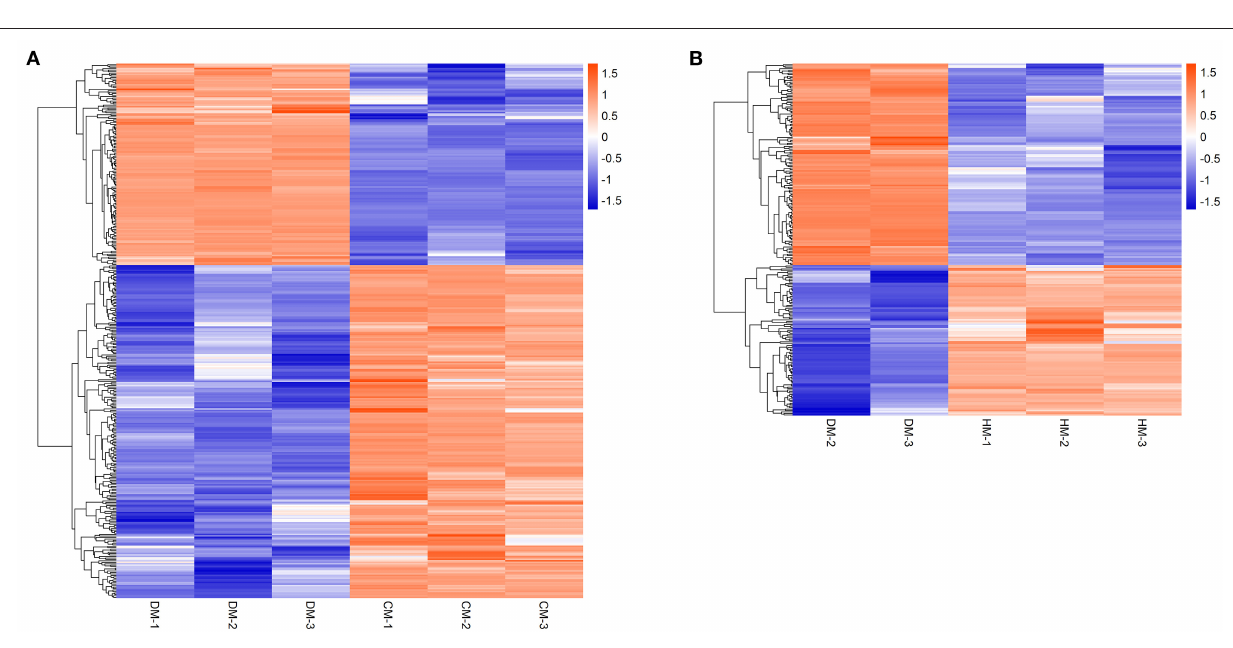
FIGURE 2 | Hierarchical clustering of DEPs in DM vs. CM group (A) and DM vs. HM group (B) . The bar color represents a logarithmic scale from − 1 to 1. Each column indicates a replicate experiment, and each row indicates a